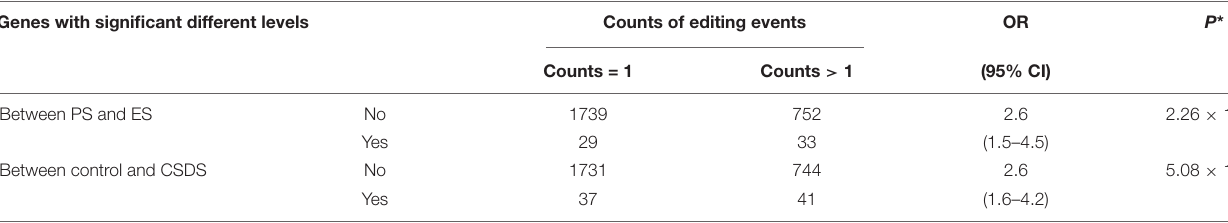
TABLE 2 | Enrichment of differential G-to-A RNA editing in genes with multiple editing events. Genes with significant different